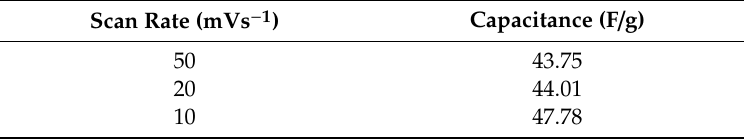
Table 4. The capacitance value of the CSAG4 sample at the scan rates of 10, 20, and 50 mV s −